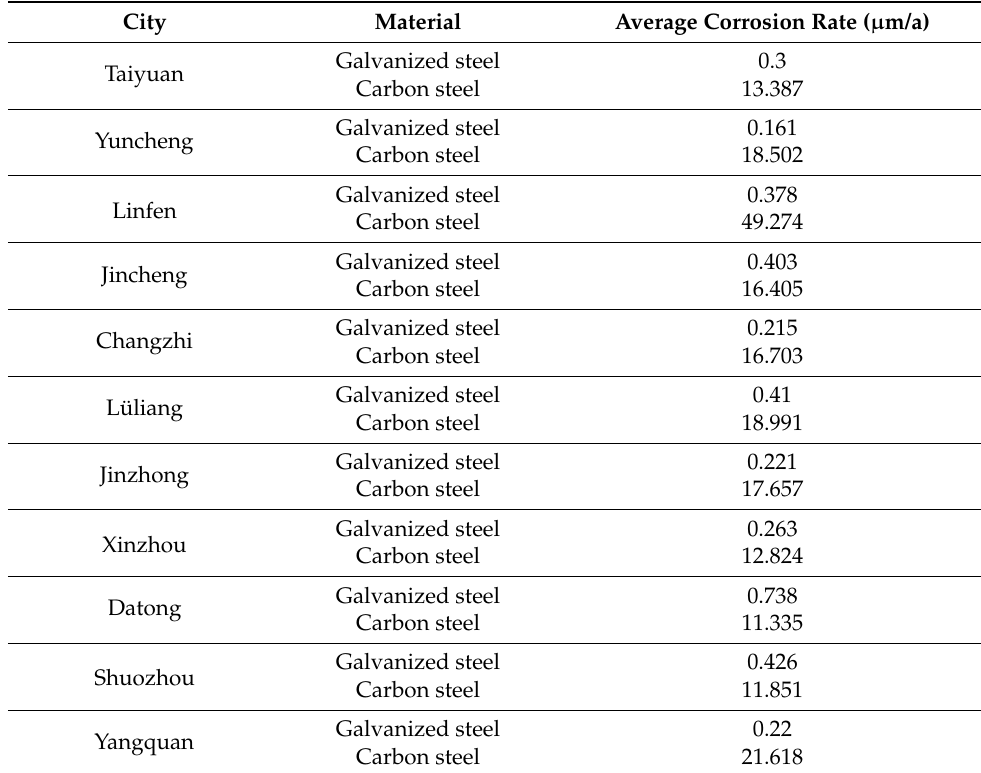
Table 3. Average corrosion rate of samples from experimental cities in Shanxi.